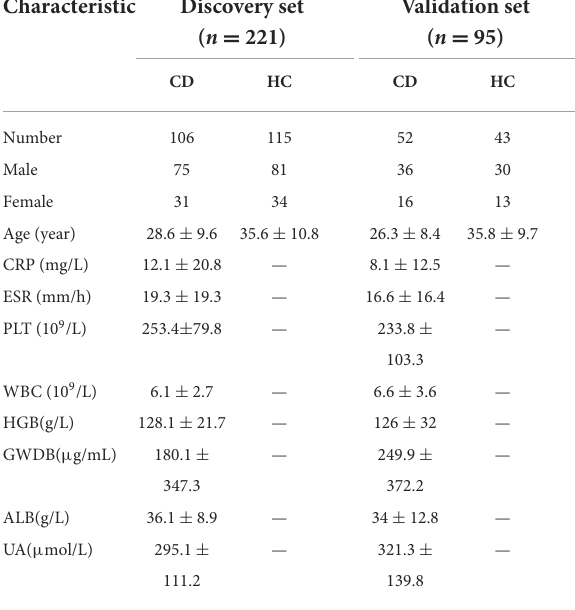
respectively. For categorical variables, chi-square tests were applied. The correlation between the levels of metabolites and the severity of CD was performed using Spearman’s rank correlation (Rs). These analyses were performed using SPSS 20.0 software (IBM, Armonk, NY, USA), and P < 0.05 was considered statistically significant. For metabolomic analysis, we reduced the resulting matrix by replacing all the missing values with a small value. The data were normalized using logarithmic transformation and Pareto scaling in MetaboAnalyst 5.0